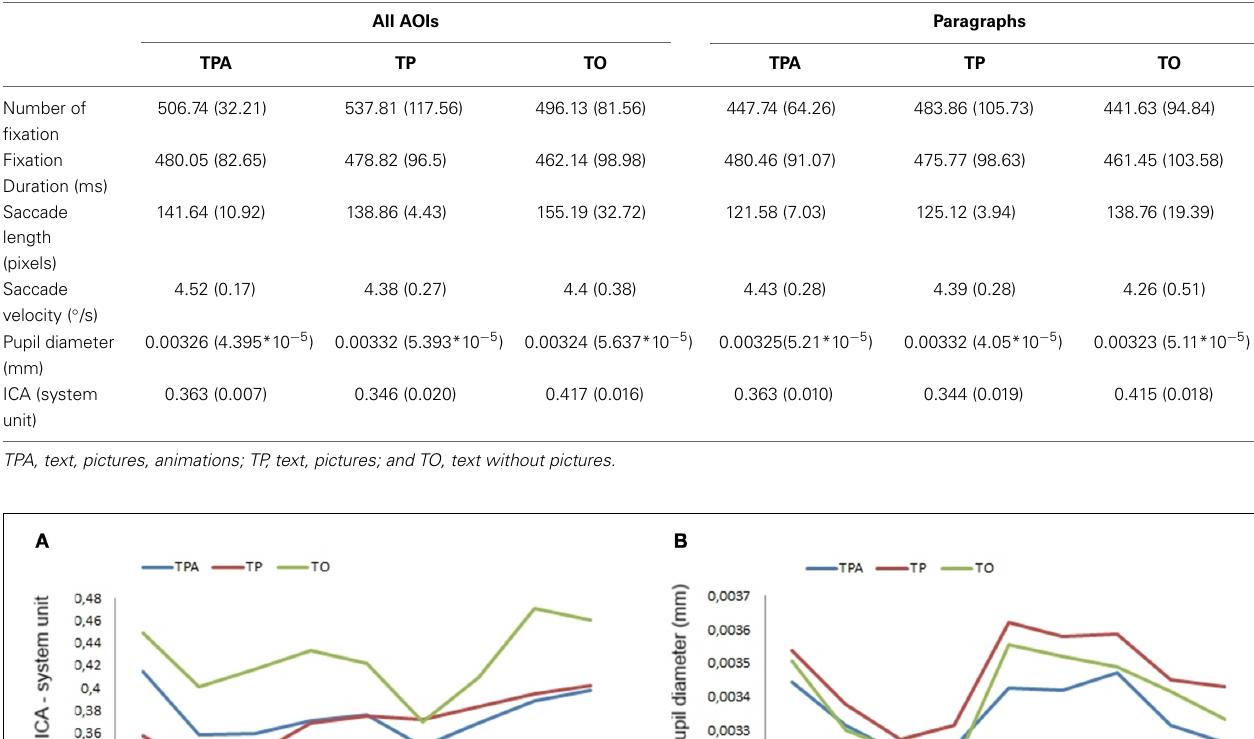
Table 3 | Means ( SD ) of the main dependent eye-related variables for all areas of interest and the paragraphs only.